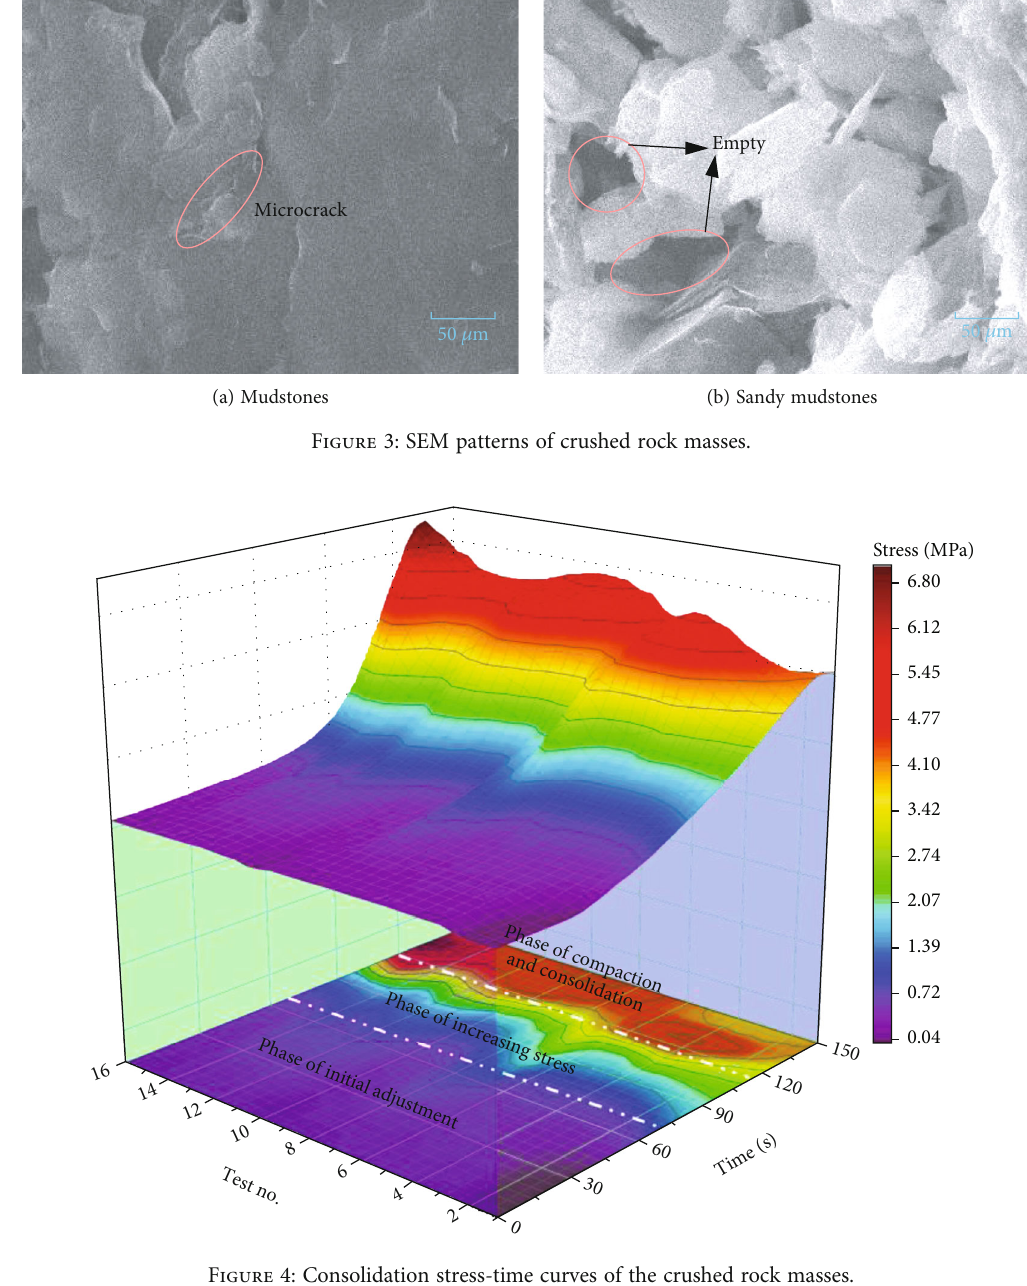
Figure 4: Consolidation stress-time curves of the crushed rock